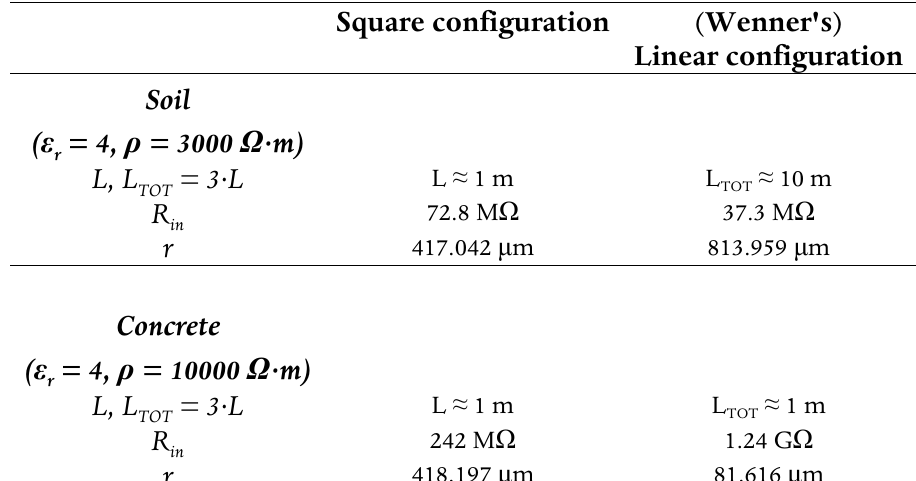
Table 2. The radius r of the probe electrodes and characteristic geometrical dimension of the quadrupole for the square (side L ) or Wenner's (length L =3 L ) configurations, using an amplifier stage with input resistance R TOT measurements on soil or